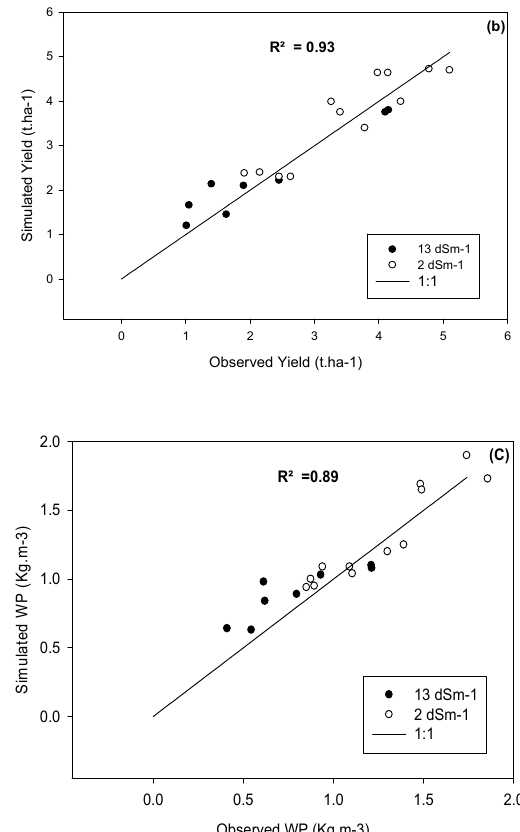
Figure 2. Correlation between observed and simulated ( a ) biomass yield; ( b ) grain yield; and ( c ) water productivity compared with 1:1 line.